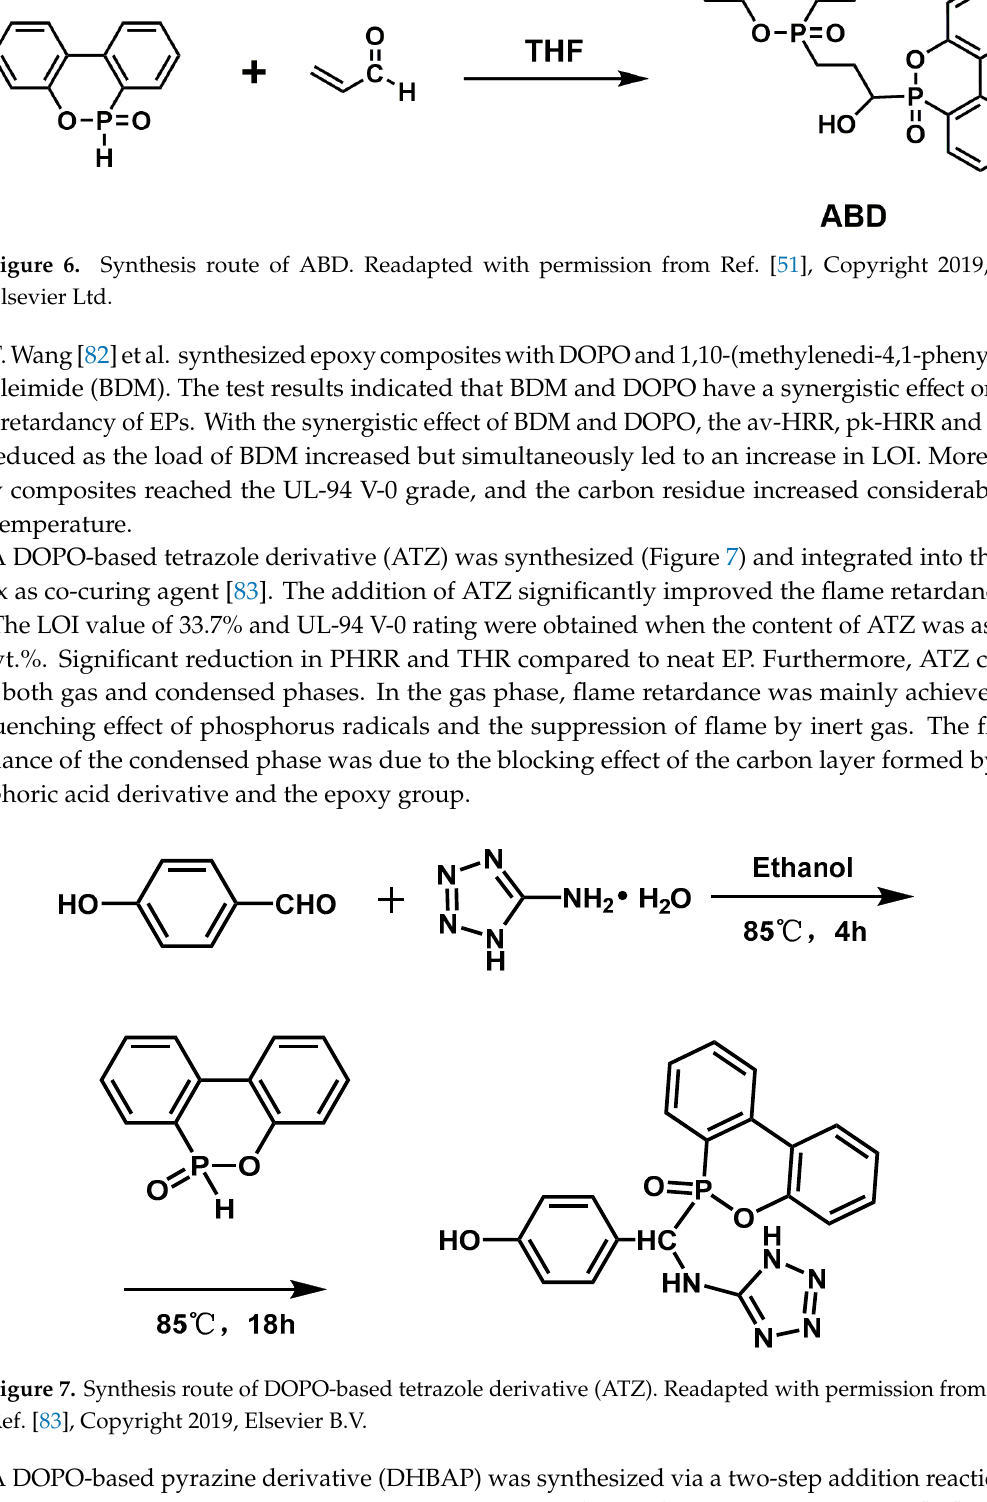
8 of 39 Figure 5. Structures of two phosphorus-containing flame retardants: ( a ) DOPP and ( b ) DOPI. Readapted with permission from Ref. [81], Copyright 2011, Elsevier Ltd. A new DOPO derivative named ABD based on DOPO and acrolein was synthesized (Figure 6) by L. Qian [51] et al. and applied it to EP. The experimental results showed that the EP with 3 wt.% ABD exhibited the best flame retardancy: LOI obtained 36.5% and passed UL-94 V-0 rating. The